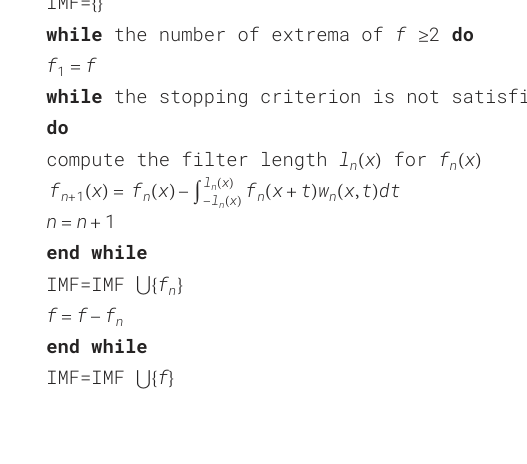
Algorithm1. ALIFAlgorithmIMF=ALIF( f